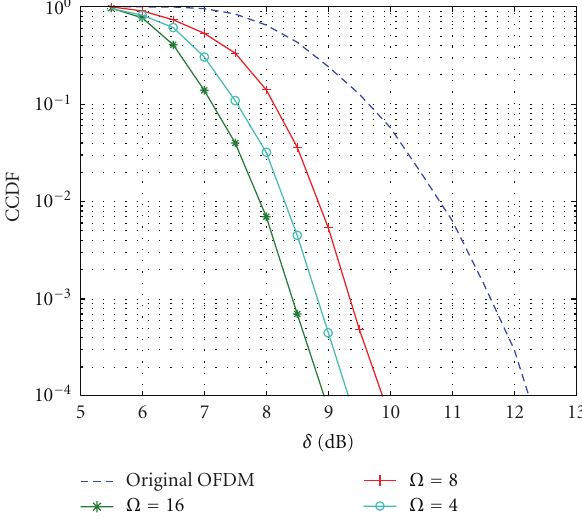
Figure 7: PAPR CCDF of SLM for various Ω with N = 256 and J =